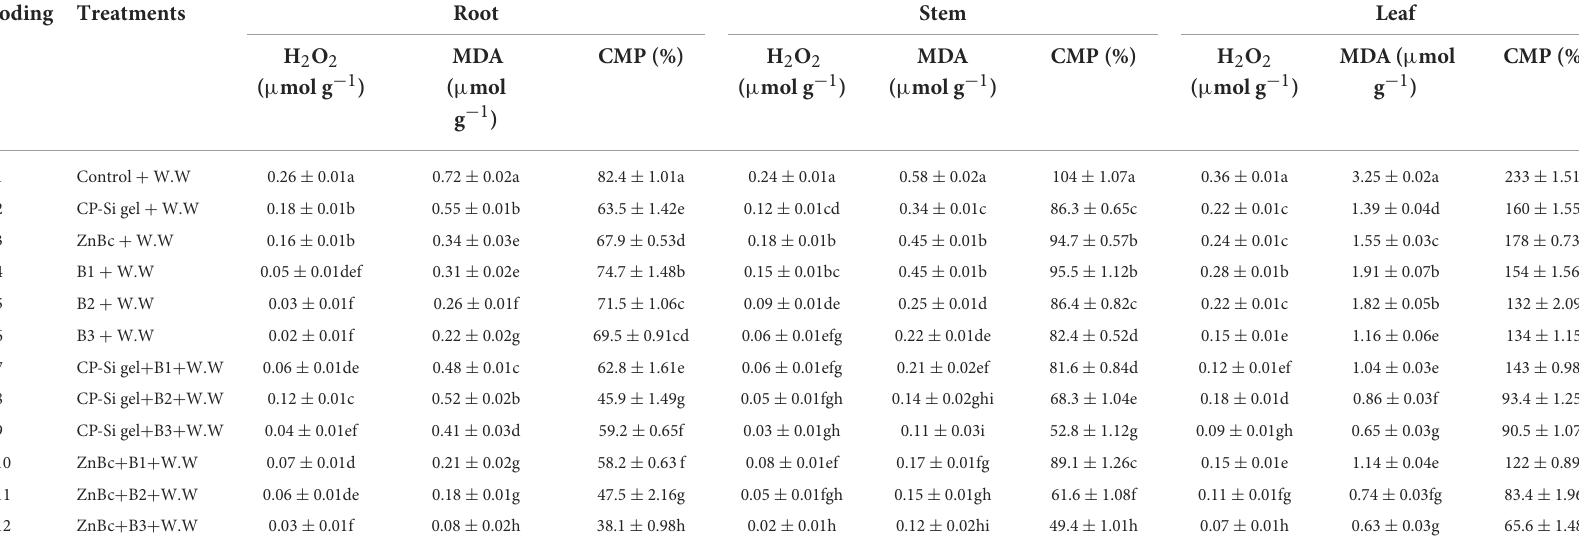
TABLE 4 Hydrogen peroxide (H 2 O 2 ), malondialdehyde (MDA) and cell membrane permeability (CMP) of root, stem, and leaf of Solanum melongena L. plant were determined under different treatments against wastewater stress. Coding